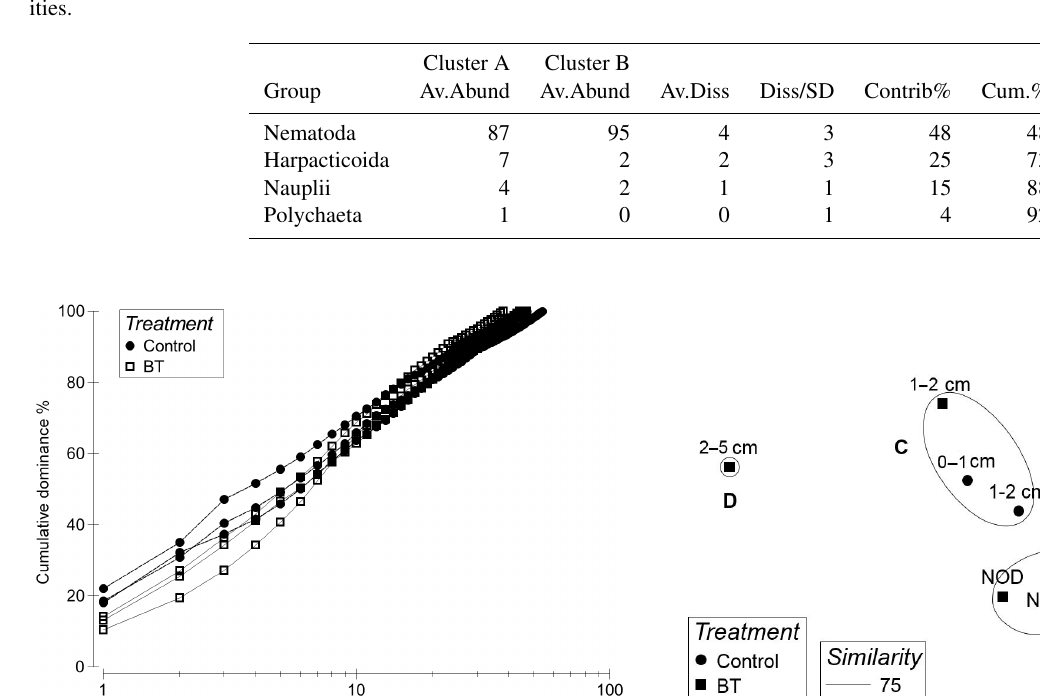
Table 1. Results of the SIMPER analysis between the significantly different clusters identified in the dataset of relative meiobenthos abun- dances in different depth layers. Av.Abund is the average abundance, Av.Diss the average dissimilarity, Diss/SD the average contribution divided by the standard deviation, Contrib% the contribution to the dissimilarities and Cum.% the cumulative contribution to the dissimilar- ities.